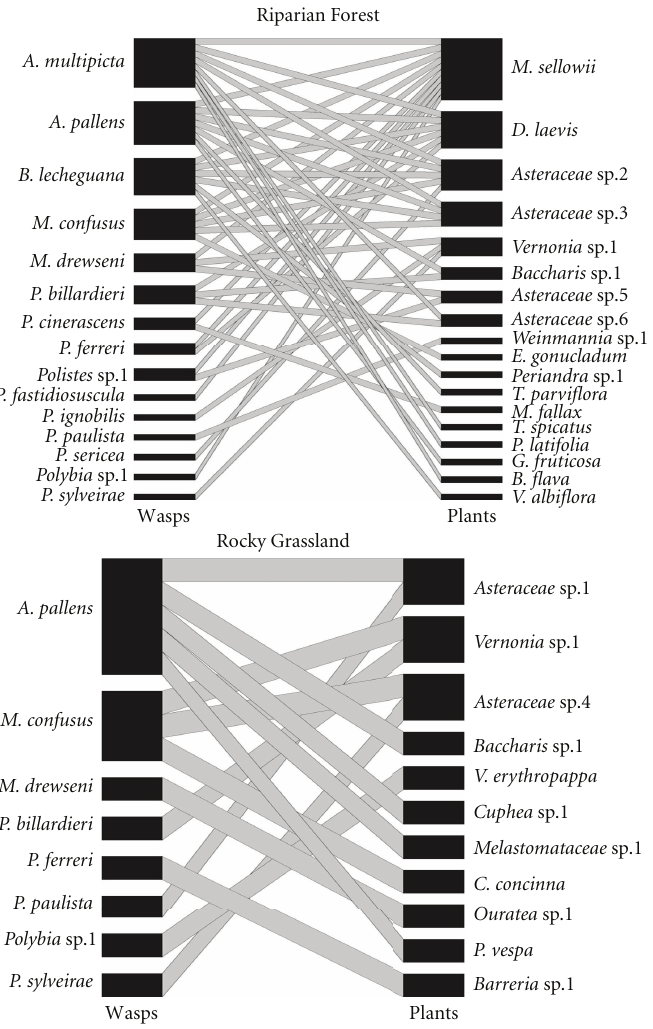
Figure 1: Wasp-plant interaction networks at Ibitipoca State Park, Minas Gerais, Brazil, during the period from November 2007 to October 2008. Riparian Forest: 18 plant species and 15 wasp species, Rocky Grassland: 11 plant species and eight wasp species (see Table 3 for classification and authors of